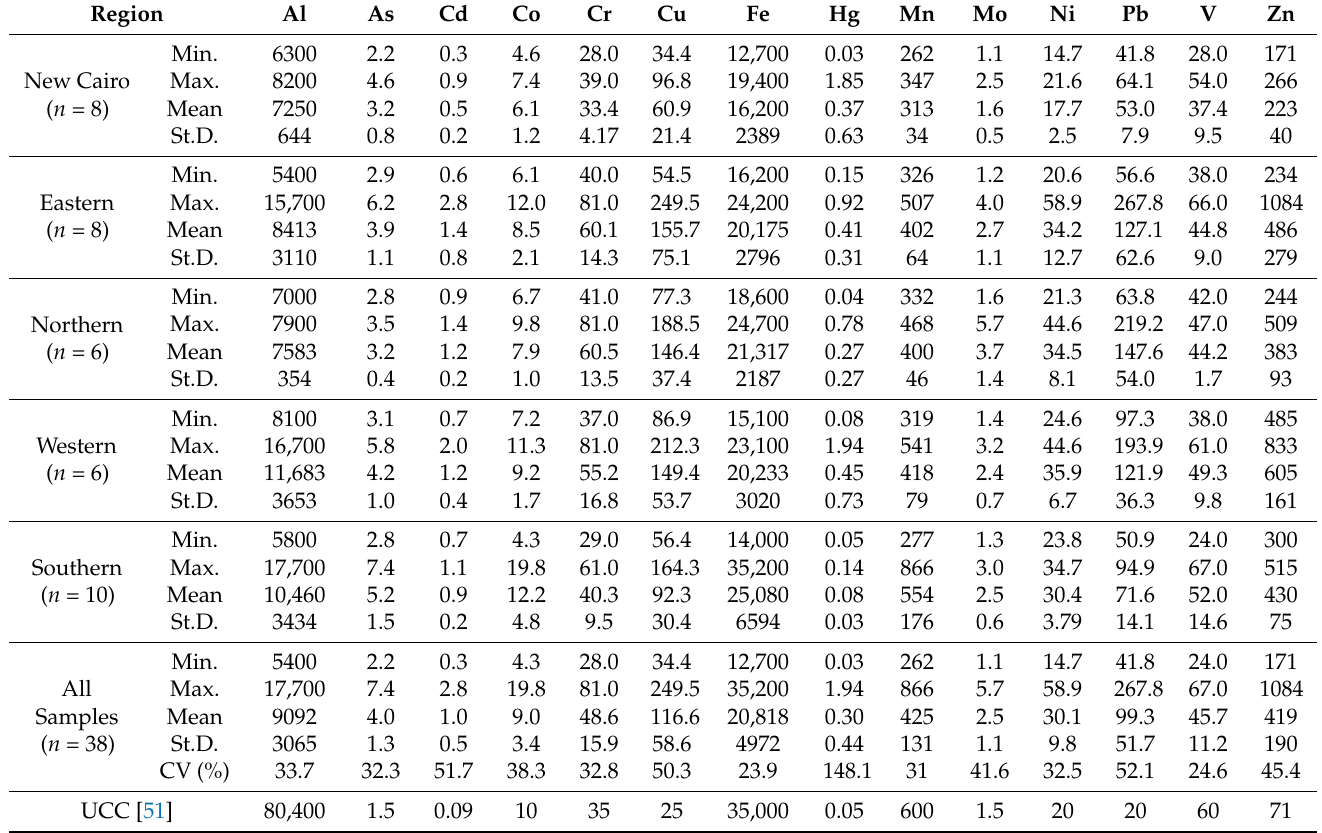
Table 2. Descriptive statistics of PTEs (ppm) in household dust in Cairo City.